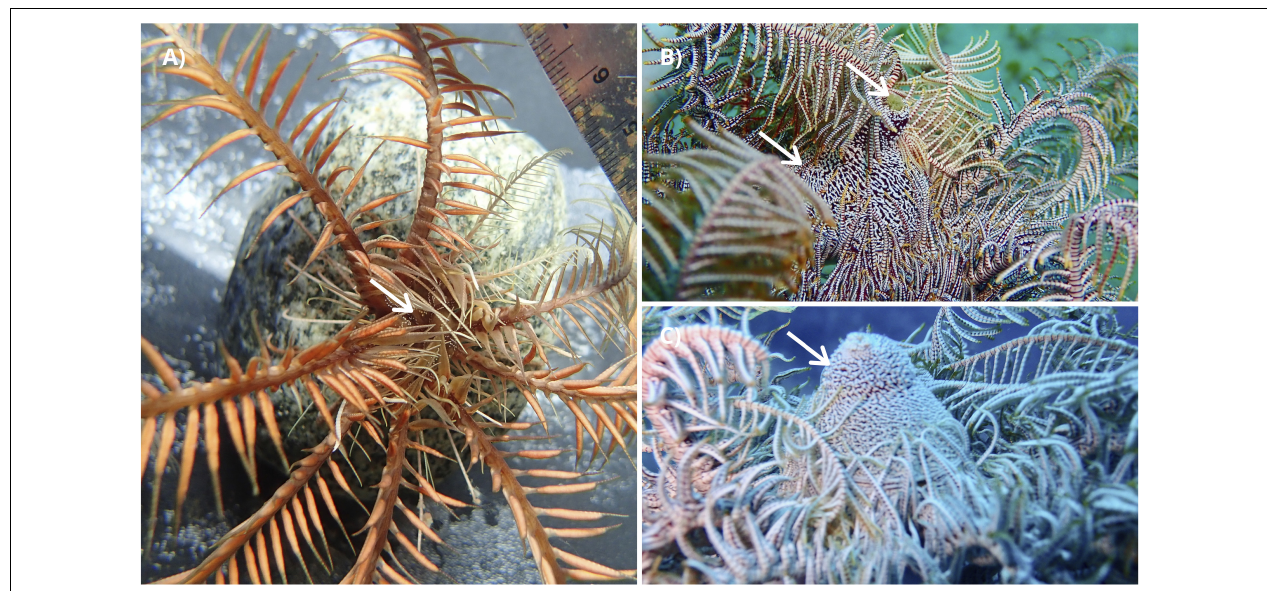
FIGURE 4 | Stomach of Florometra serratissima in the lab (A) , and two individuals of Clarkcomanthus mirabilis in the field (B,C) . Note the bulging stomachs of C. mirabilis , with feces protruding [ (B) , top arrow] versus the absence of this in F. serratissima (A) . Arrows point to the stomach of each